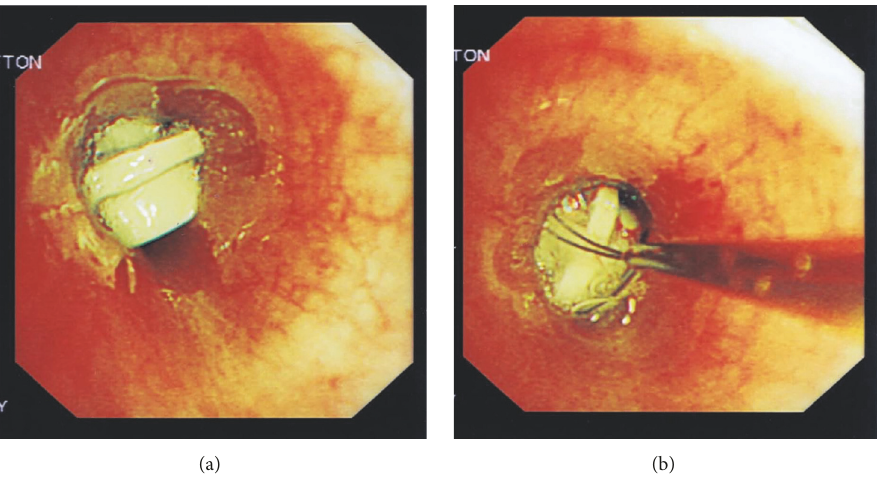
Figure 2: (a) Photograph showing the wedging of a “LEGO” in the left main bronchus of our patient (CS) and surrounding mucosal inflammation. (b) Photograph showing the capture of the “LEGO” in the left main bronchus of our patient (CS) by the Dormia Basket